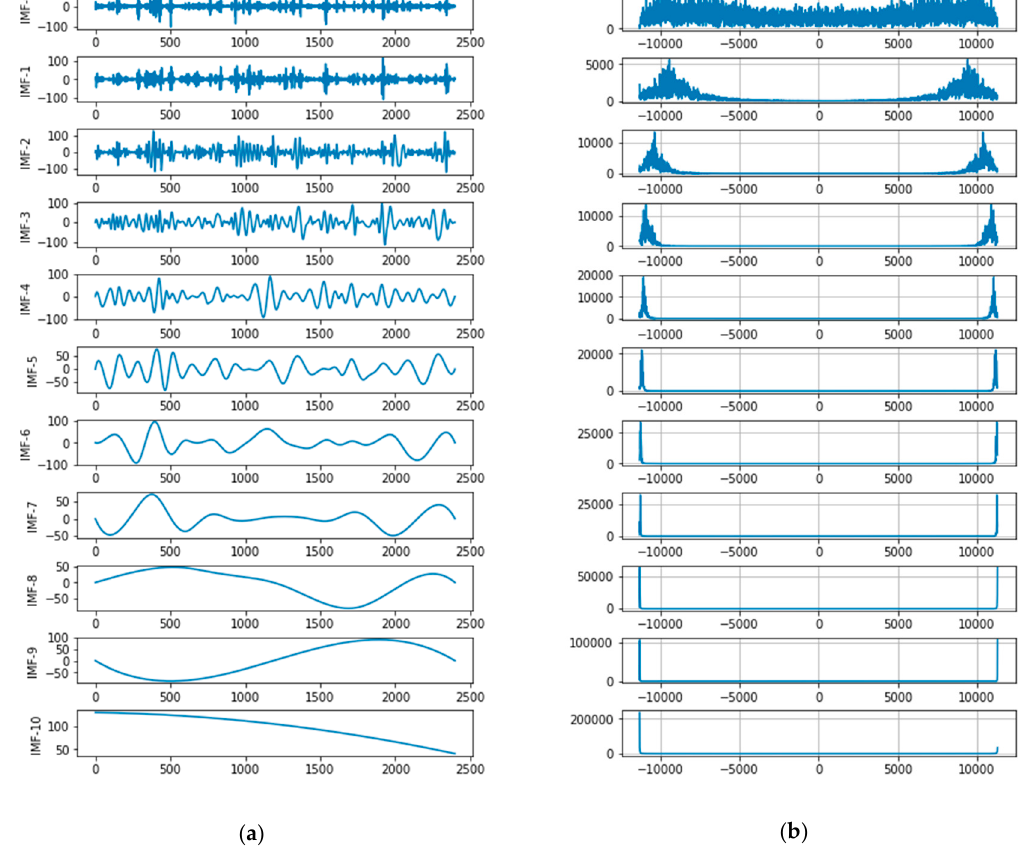
Figure 1. Correspondence of each intrinsic mode function (IMF) between time domain and frequency domain after decomposition. Left to right: IMFs in the ( a ) time domain, ( b ) frequency domain by the fast Fourier transform (FFT).